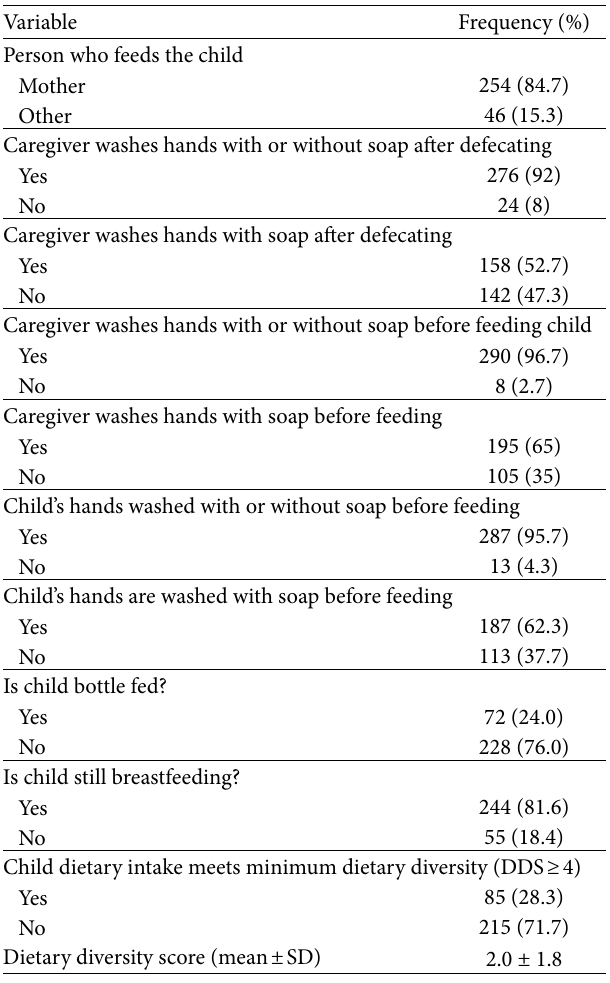
Table 4: Child feeding and hygiene practices among the mothers/ caregivers of the